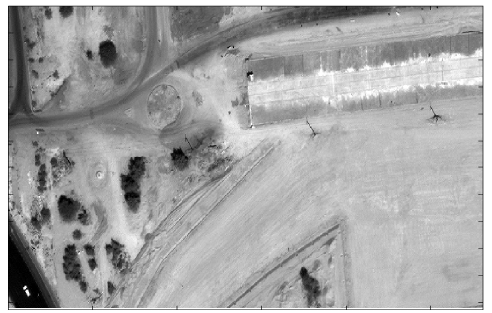
Figure 4. Right Pleiades satellite stereo image contains four power poles and vegetation near power two poles